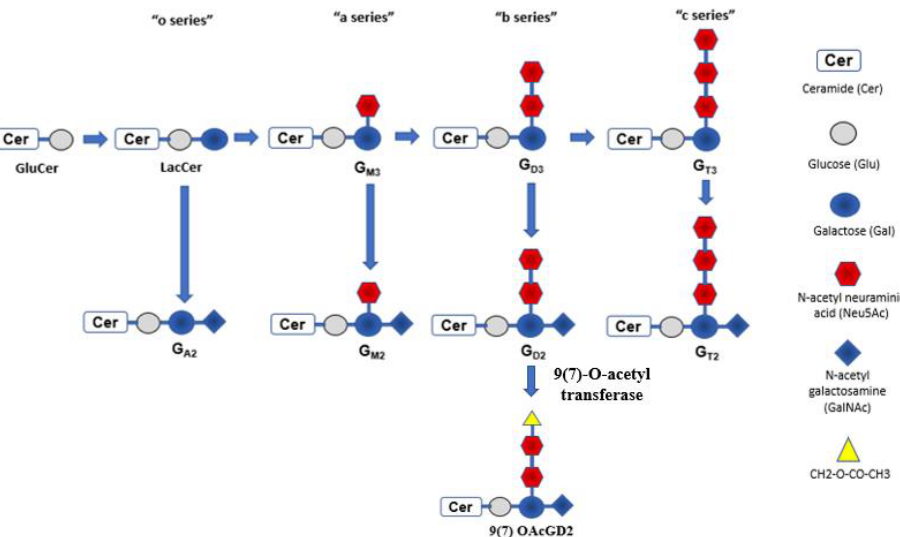
Figure 1. Gangliosides can be classified into four series: 0-, a-, b-, and c-series. They differ based on the number of N-acetylneuraminic acids (Neu5Acs) involved in sialic acid chain. GD2 and GD3 have two Neu5Acs and differ by the presence of N-acetyl galactosamine (GalNAc) or not. GD2 has GalNAc and adding O -acetyl group to N-acetyl Neu5Ac will form the subgroup of GD2 antigen known as O-acetylated GD2 (OAcGD2). It can be targeted by monoclonal antibody 8B6mAb. LacCer, lactosylceramide.